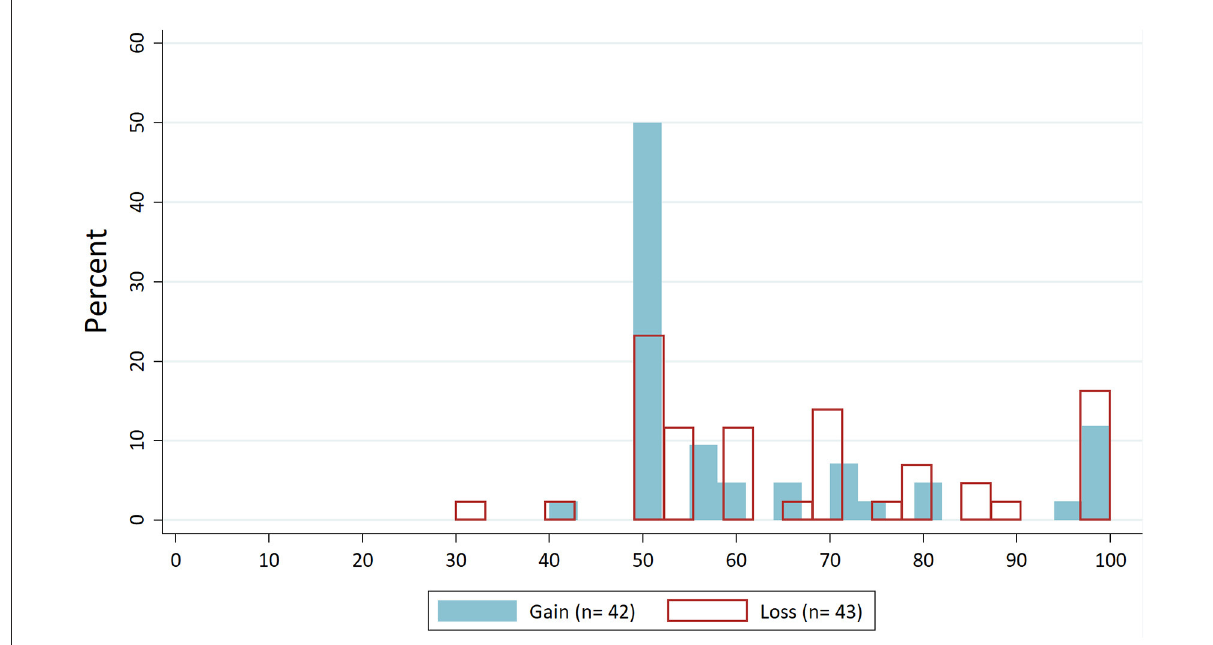
FIGURE3 Distribution dictators’ demands in “Average behaviour”.